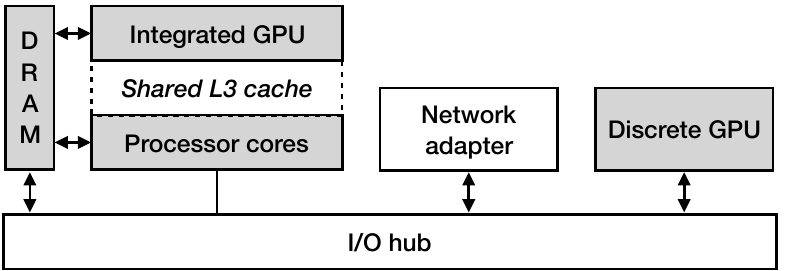
Figure 5. An illustration of the packet processing scheme in a hardware setup that contains one main processor packed in the same die with an integrated GPU and one discrete high-end